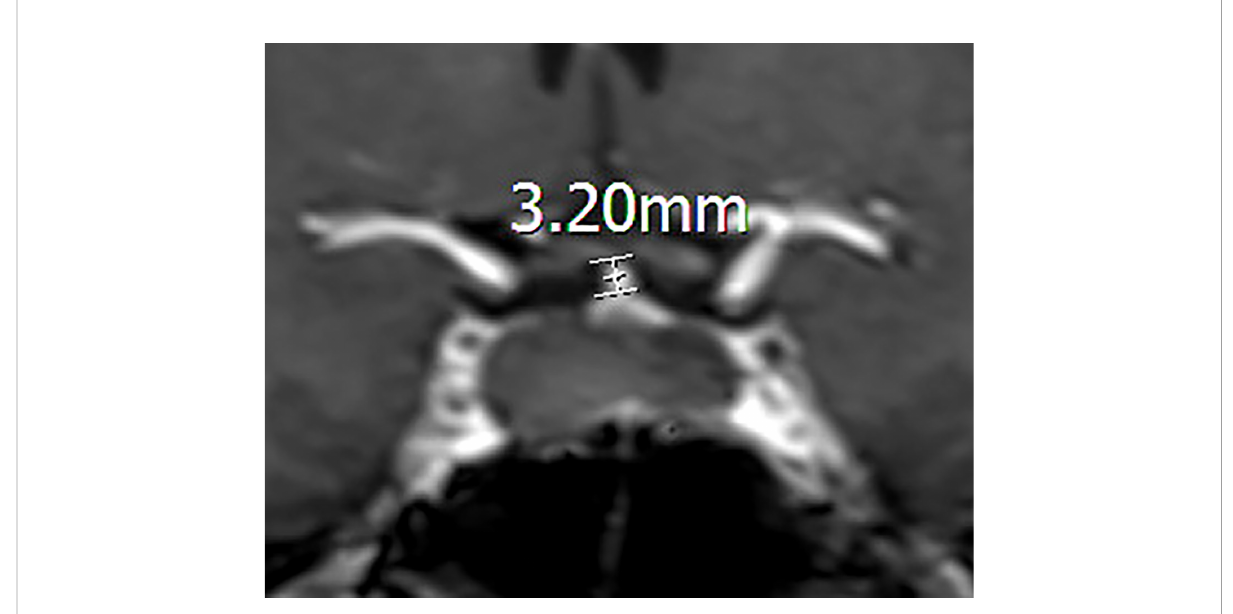
FIGURE 3 Coronal contrast-enhanced image showing the measurement of the pituitary stalk. The length of a preoperative pituitary stalk is